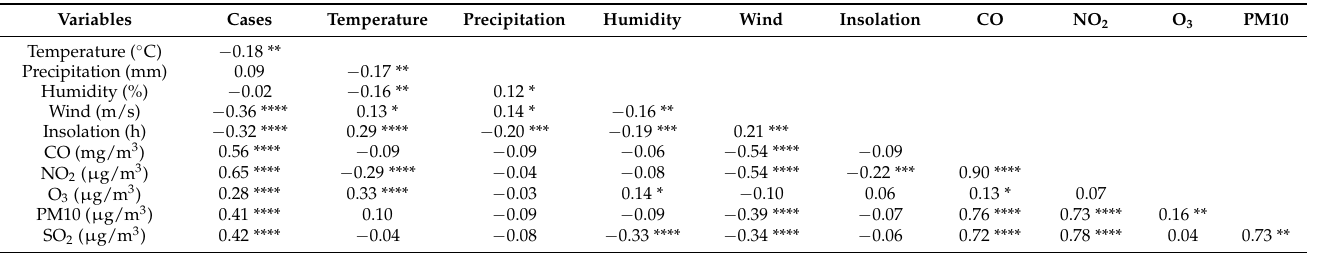
Table 2. Spearman correlations of meteorological and Air Quality Parameters, and Daily